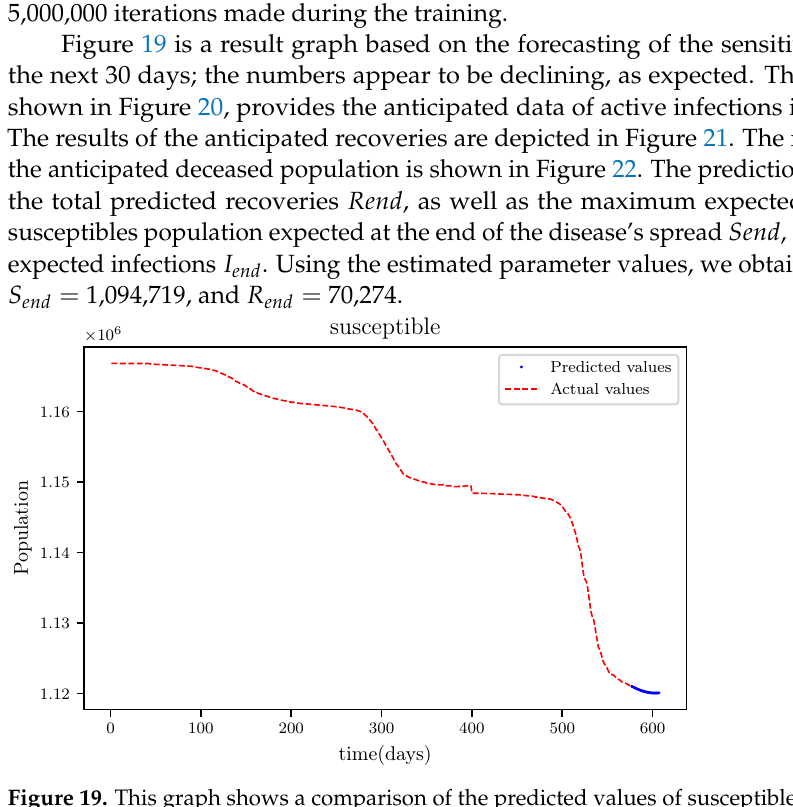
Figure 19. This graph shows a comparison of the predicted values of susceptible population and the actual data of susceptible population for a SIRD model with future